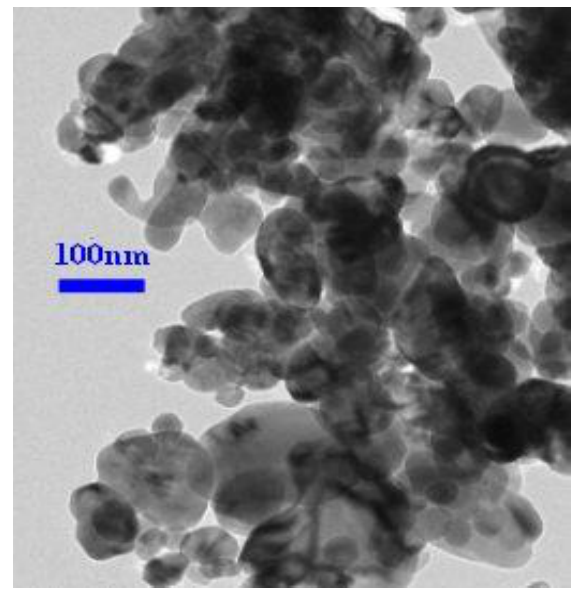
Figure 1. Scanning electron microscope (SEM) image of a copper oxide nanoparticle.